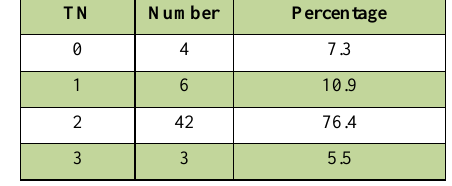
Table 2. Condition of the therapeutic needs of the subjects.